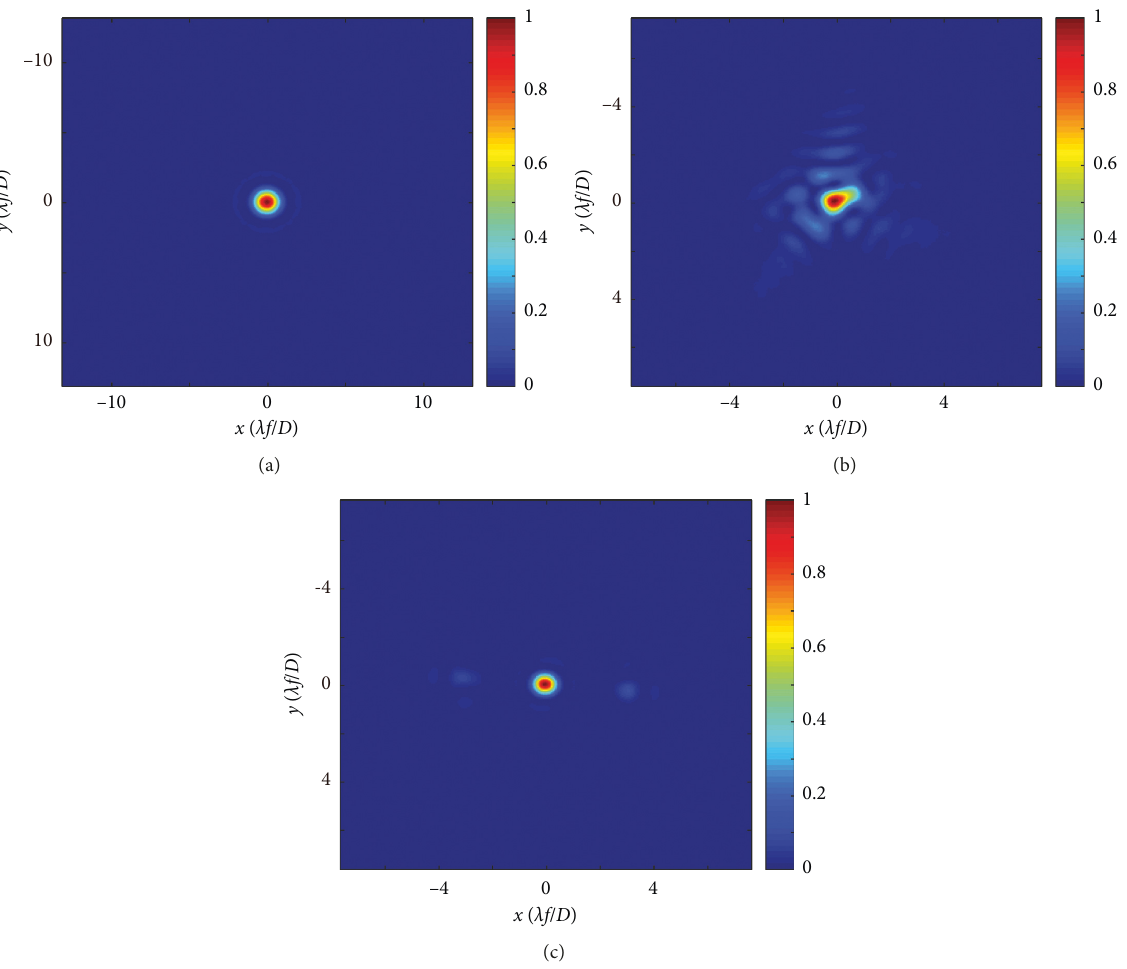
Figure 1: Intensity distribution with different Zernike combinations: (a) ideal beam pattern without phase aberrations, (b) beam pattern 1 with the 1 st to 14 th order Zernike phase, and (c) beam pattern 2 with the 91 st to 104 th order Zernike